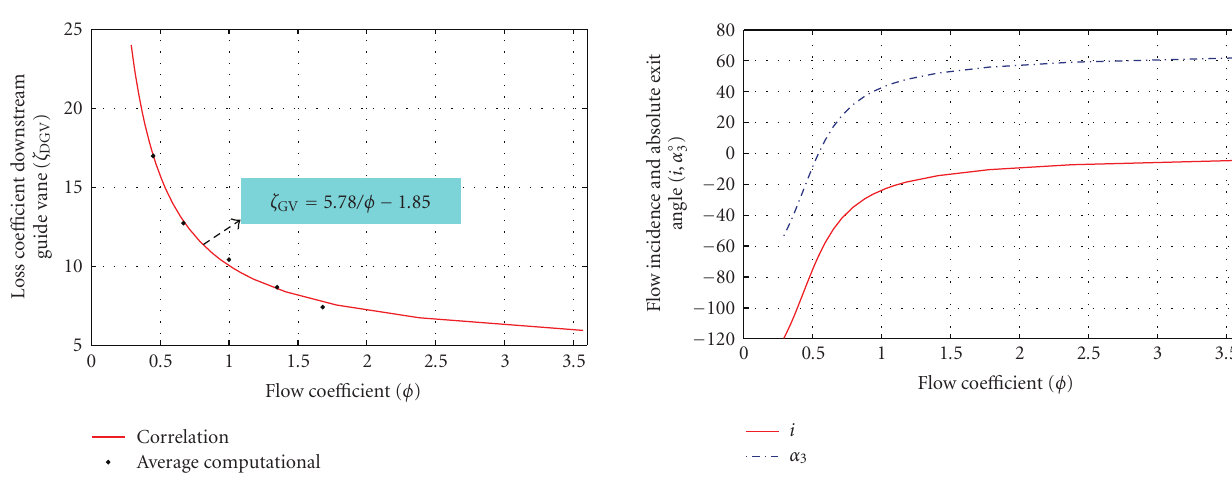
Figure 6: Flow incidence and absolute exit angle versus flow coe ffi